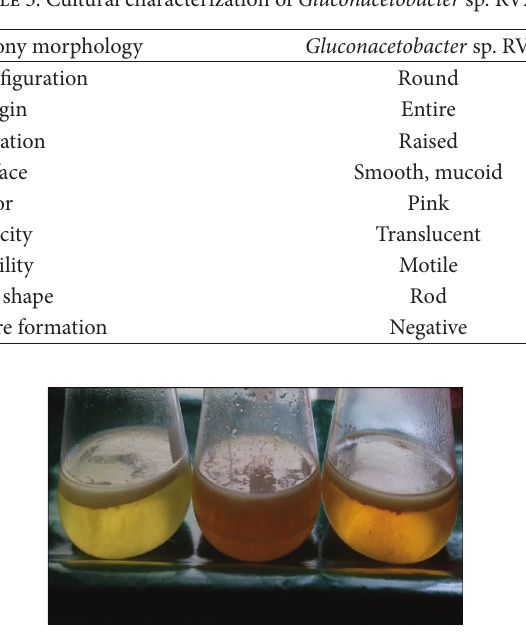
Figure 3: Pellicle formed at air liquid interface by the isolates Gluconacetobacter sp., Enterobacter sp., and Pseudomonas sp.